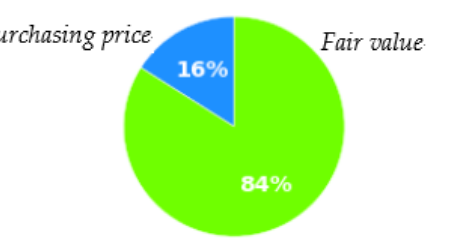
Figure 8. Answers for question of how to disclose the values of cryptocurrencies in accounting?